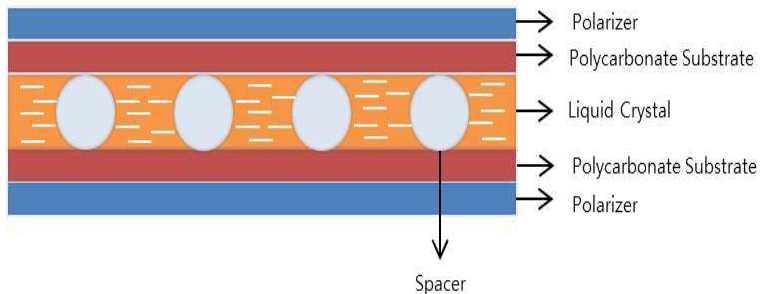
Figure 2. Vertical view of the flexible liquid crystal